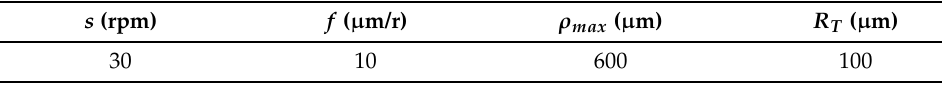
Table 1. The machining parameters used in the simulation.